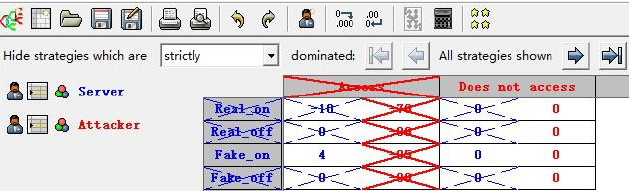
Figure 7. Dominance result when N = 20.